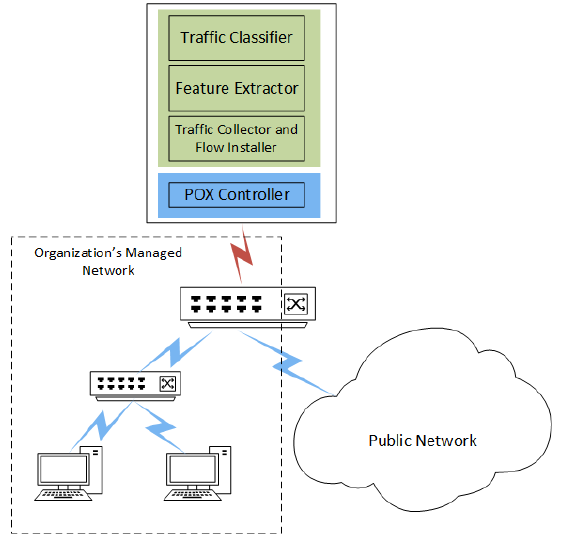
Figure 3. A DDoS detection system implemented in SDN